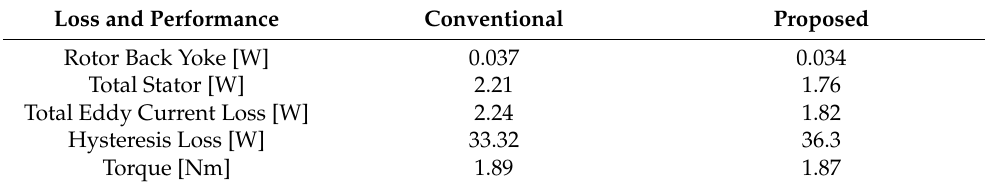
Table 4. Performance comparison